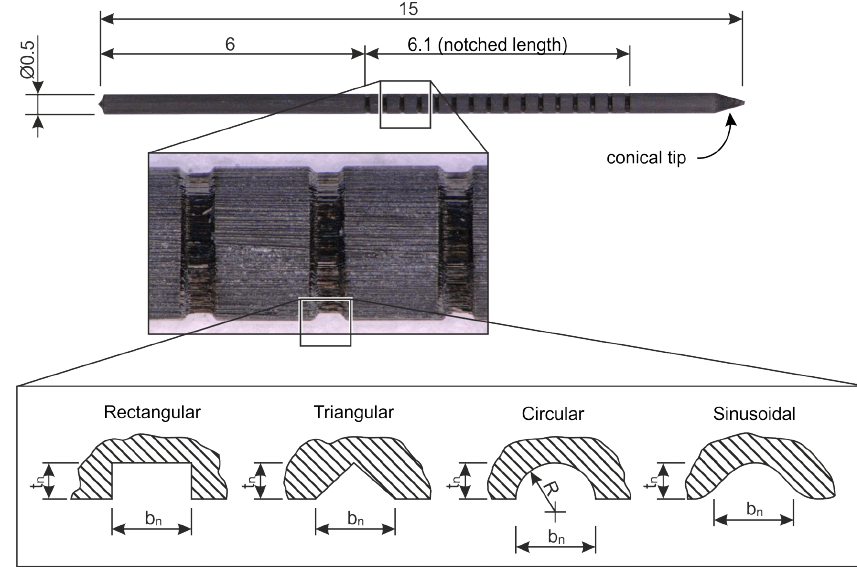
Figure 1. Definition of the z-pins with notched region at the surface as well as the different notch designs